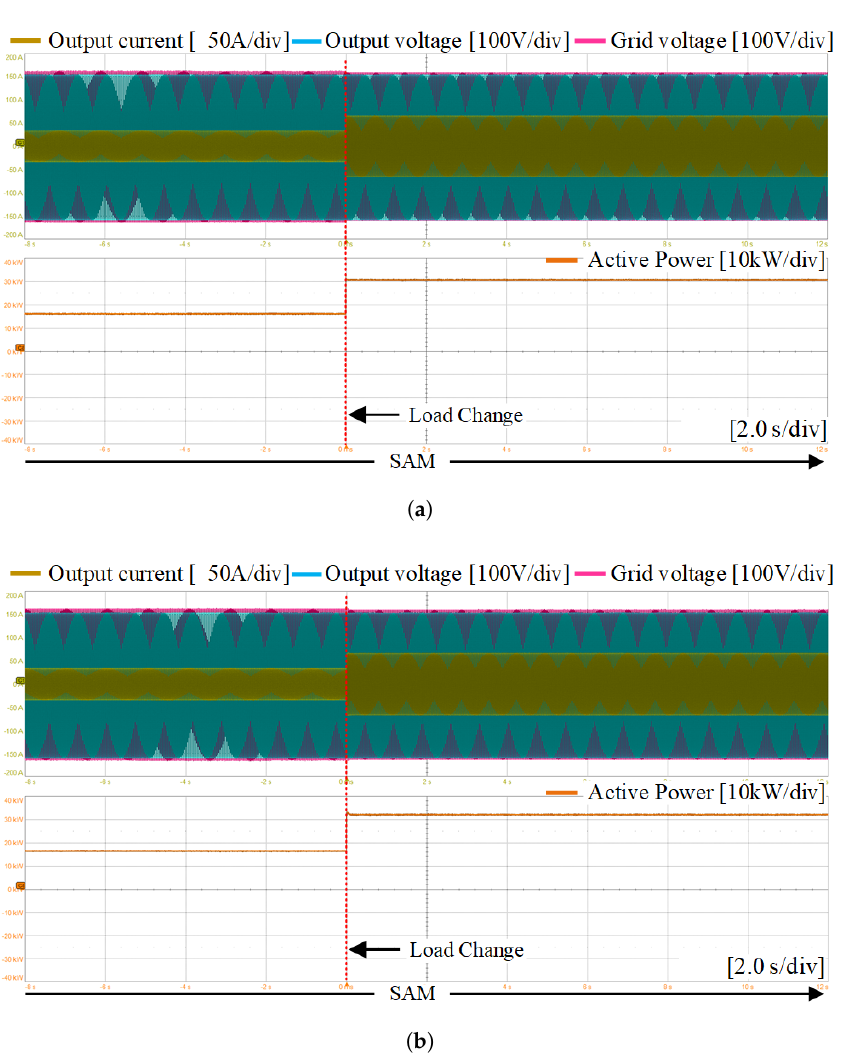
Figure 11. HILS based experimental results with only resistive load condition ( a ) conventional ( b ) proposed control